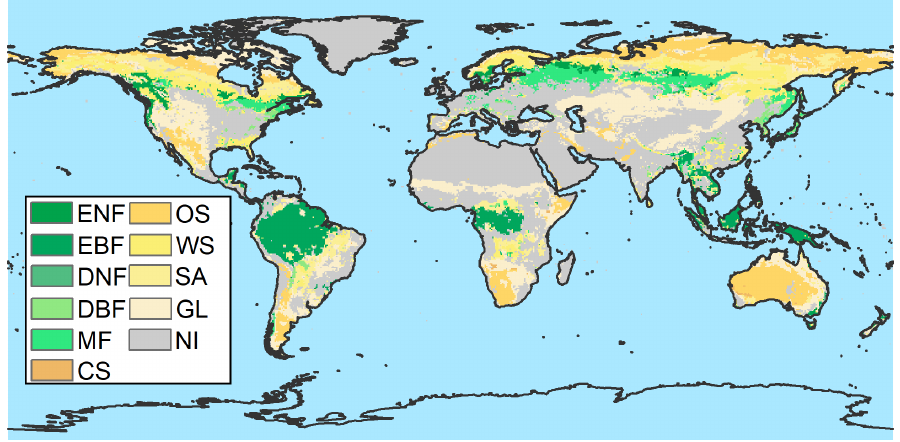
Figure A6. Map showing the largest vegetation component of each grid cell without anthropogenic disturbance from MCD12C1 and LUH2. ENF: evergreen needleleaf forest; EBF: evergreen broadleaf forest; DNF: deciduous needleleaf forest; DBF: deciduous broadleaf forest; MF: mixed forest; CS: closed shrublands; OS: open shrublands; WS: woody savannas; SA: savannas; GL: grasslands; NI: not included, which means the zone is not covered by vegetation without anthropogenic disturbance.